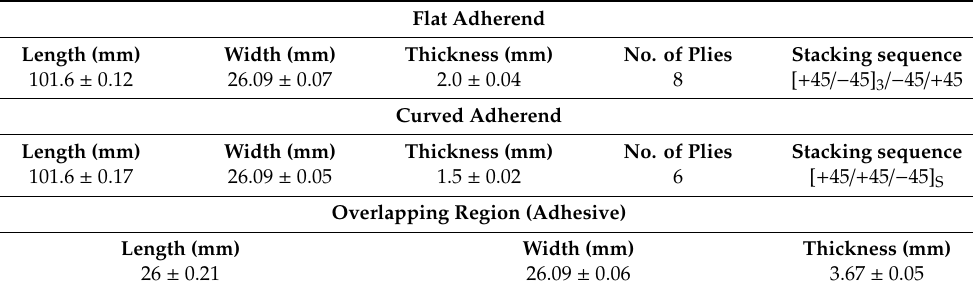
Figure 1. Single-lap shear (SLS) ( a ) and joggled-lap shear (JLS) ( b ) specimens’ nominal dimensions. Figure 1 . Single-lap shear (SLS) ( a ) and joggled-lap shear (JLS) ( b ) specimens ’ nominal dimensions . Table 1. JLS specimens’ geometry and characteristics. Table 1. JLS specimens ’ geometry and characteristics.